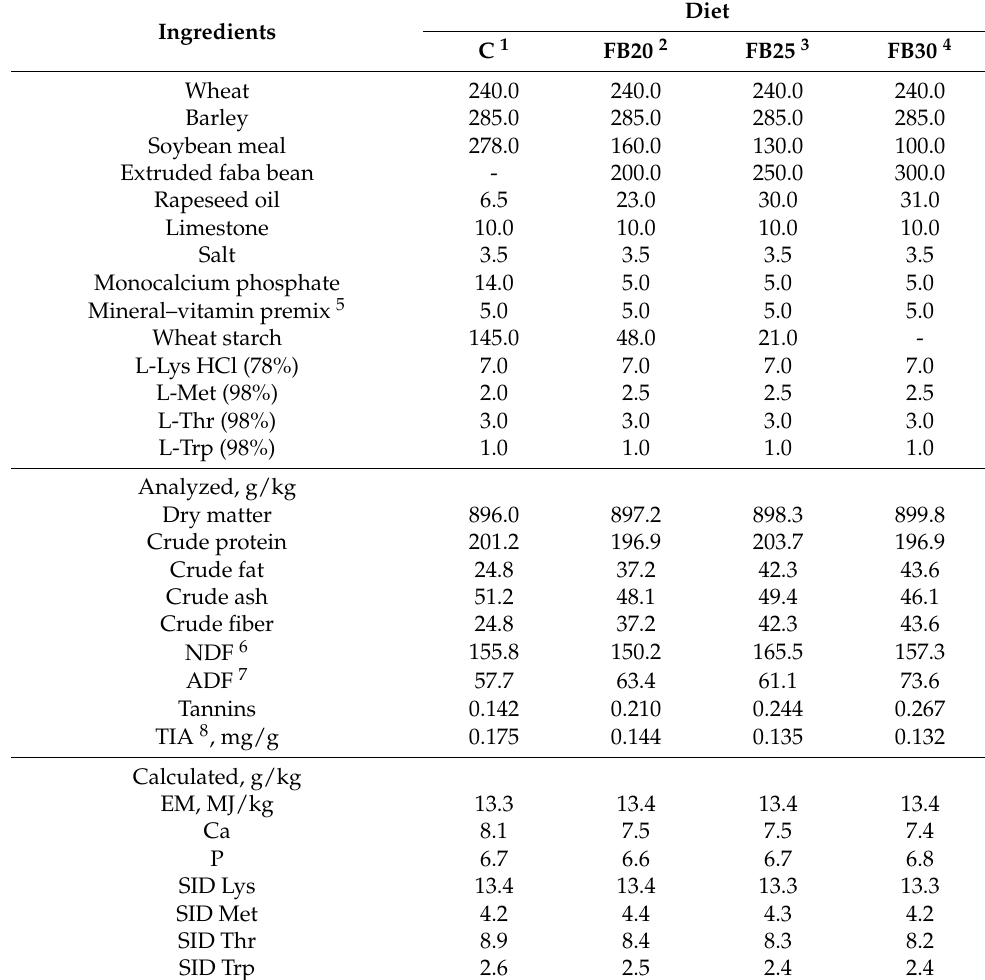
Table 1. Composition of experimental diets,